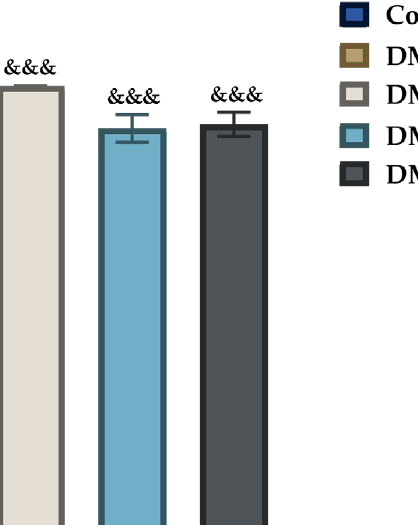
Figure 5. Paw withdrawal thresholds of normoglycemic rats administered with saline solution (con- trol) and diabetic rats administered with saline (DM), 10 mg/kg pregabalin (DM + Pregabalin), 5 mg/kg vortioxetine (DM + Vort 5) or 10 mg/kg vortioxetine (DM + Vort 10) in the Dynamic plantar test. Values are given as mean ± S.E.M. Significant difference against control group *** p < 0.001; s ignificant difference against DM group &&& p < 0.001. One-way ANOVA, post hoc Tukey ’s HSD multiple comparison test, n = 8.